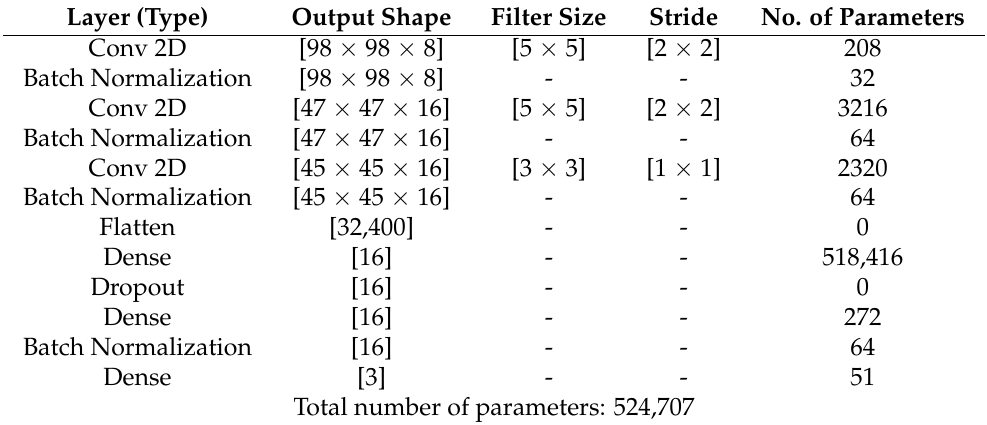
Table 3. Detailed architecture of Convolutional neural network for damage classification.